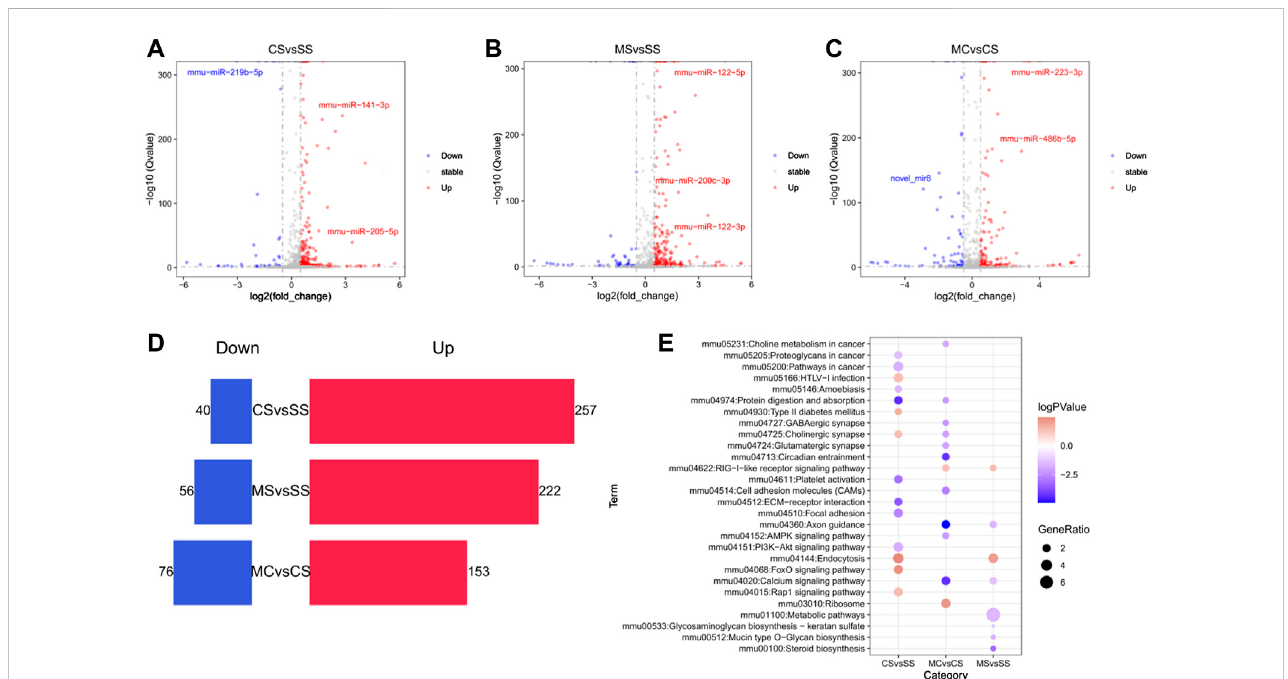
FIGURE 5 Global alteration of miRNA in cocaine addiction and MET treatment response to cocaine addiction. (A – C) Volcano plot of differentially miRNAs (DE- miRNAs)intheCS (A) ,MS (B) ,andMC (C) groups( q < 0.05and|log2fold_change > =0.5|).Blue,downregulatedmiRNAs;red,upregulatedmiRNAs. (D) Barchart of the number of DE-miRNAs in the CS, MS, and MC groups. (E) Bubble diagram of enriched pathways of the predicted target DEGs of DE-miRNAs in the CS, MS, and MC groups ( q <